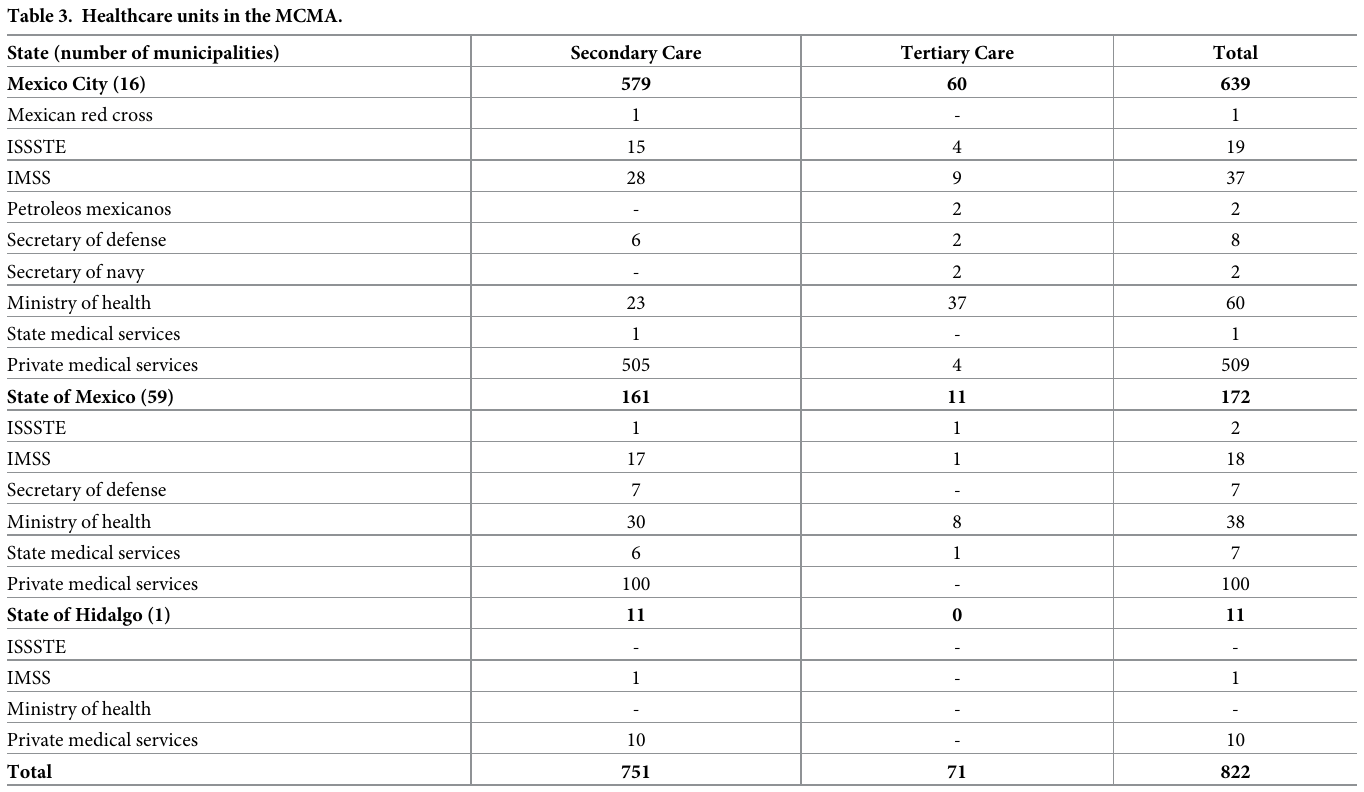
Table 3. Healthcare units in the